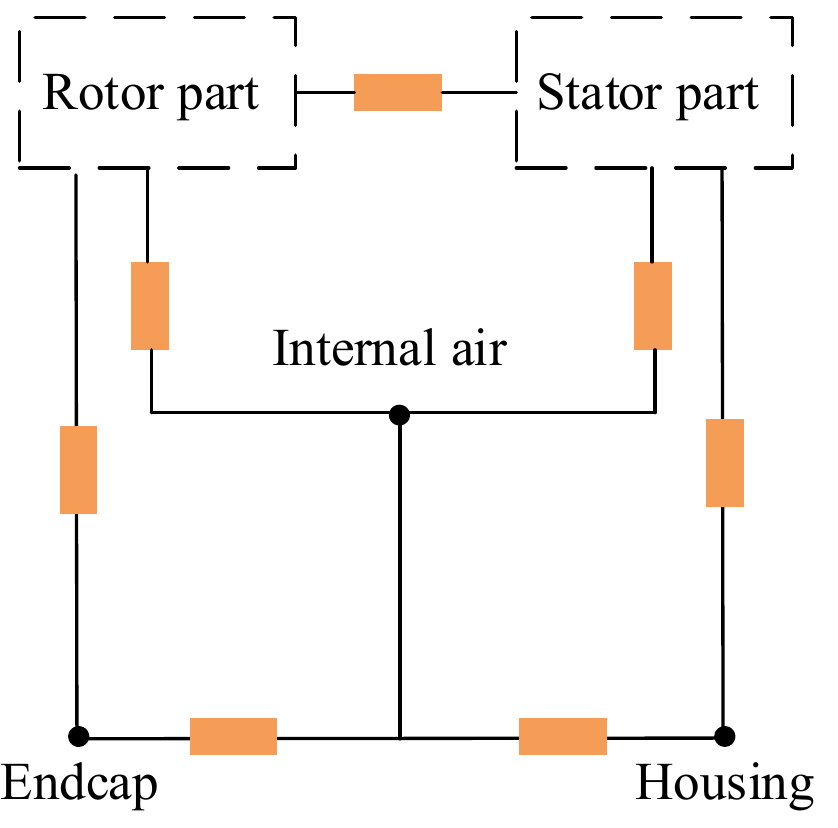
Figure 10. LPTN model of the motor. ( a ) Healthy slot. ( b ) SC slot.